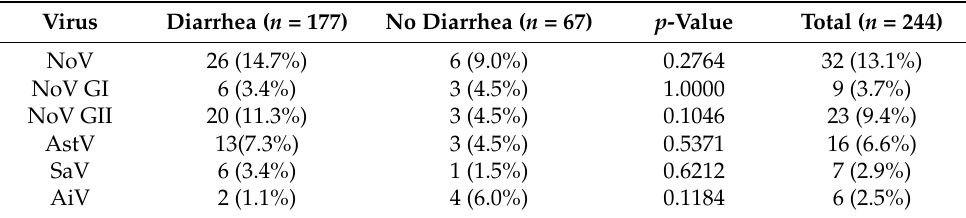
Table 1. Detection rate of enteric viruses among children with/without